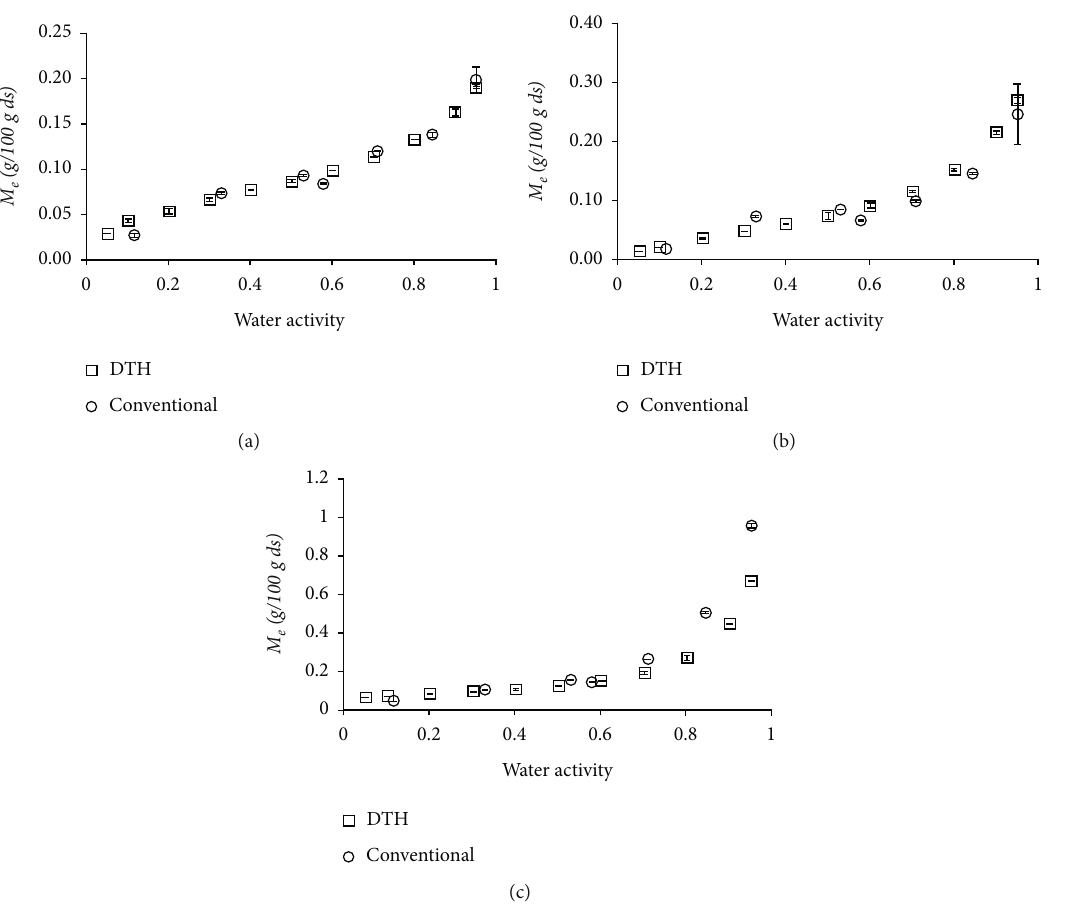
Figure 4: Adsorption isotherms as measured by DTH chamber and conventional isopiestic method ((a) cellulose, (b) lignin, and (c)